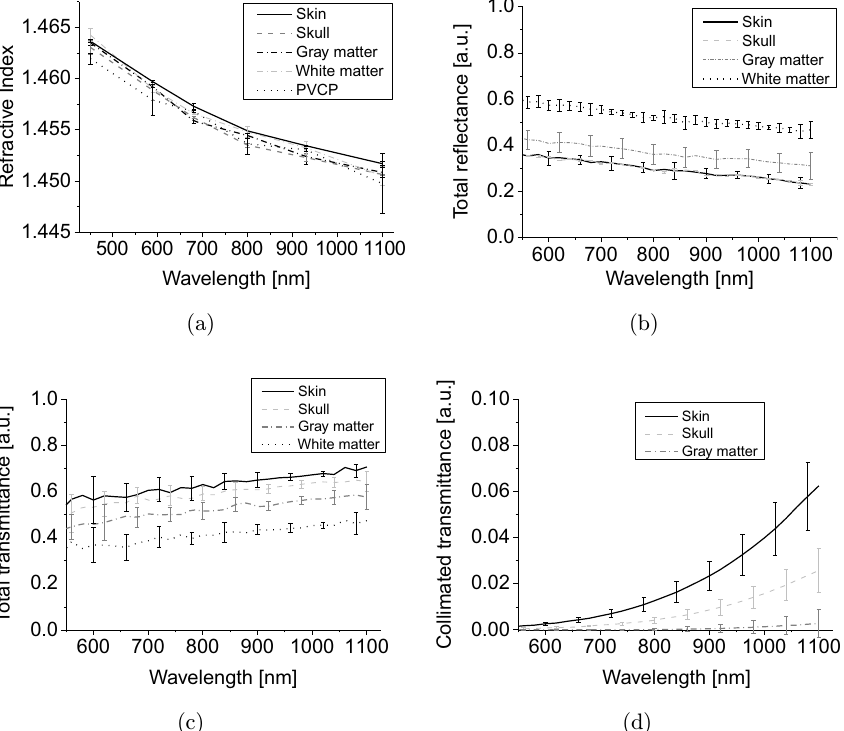
Fig. 3. Measured refractive index (a), total re°ectance (b), total transmittance (c), and collimated transmittance (d), as input (along with thickness) for inverse adding-doubling algorithms.